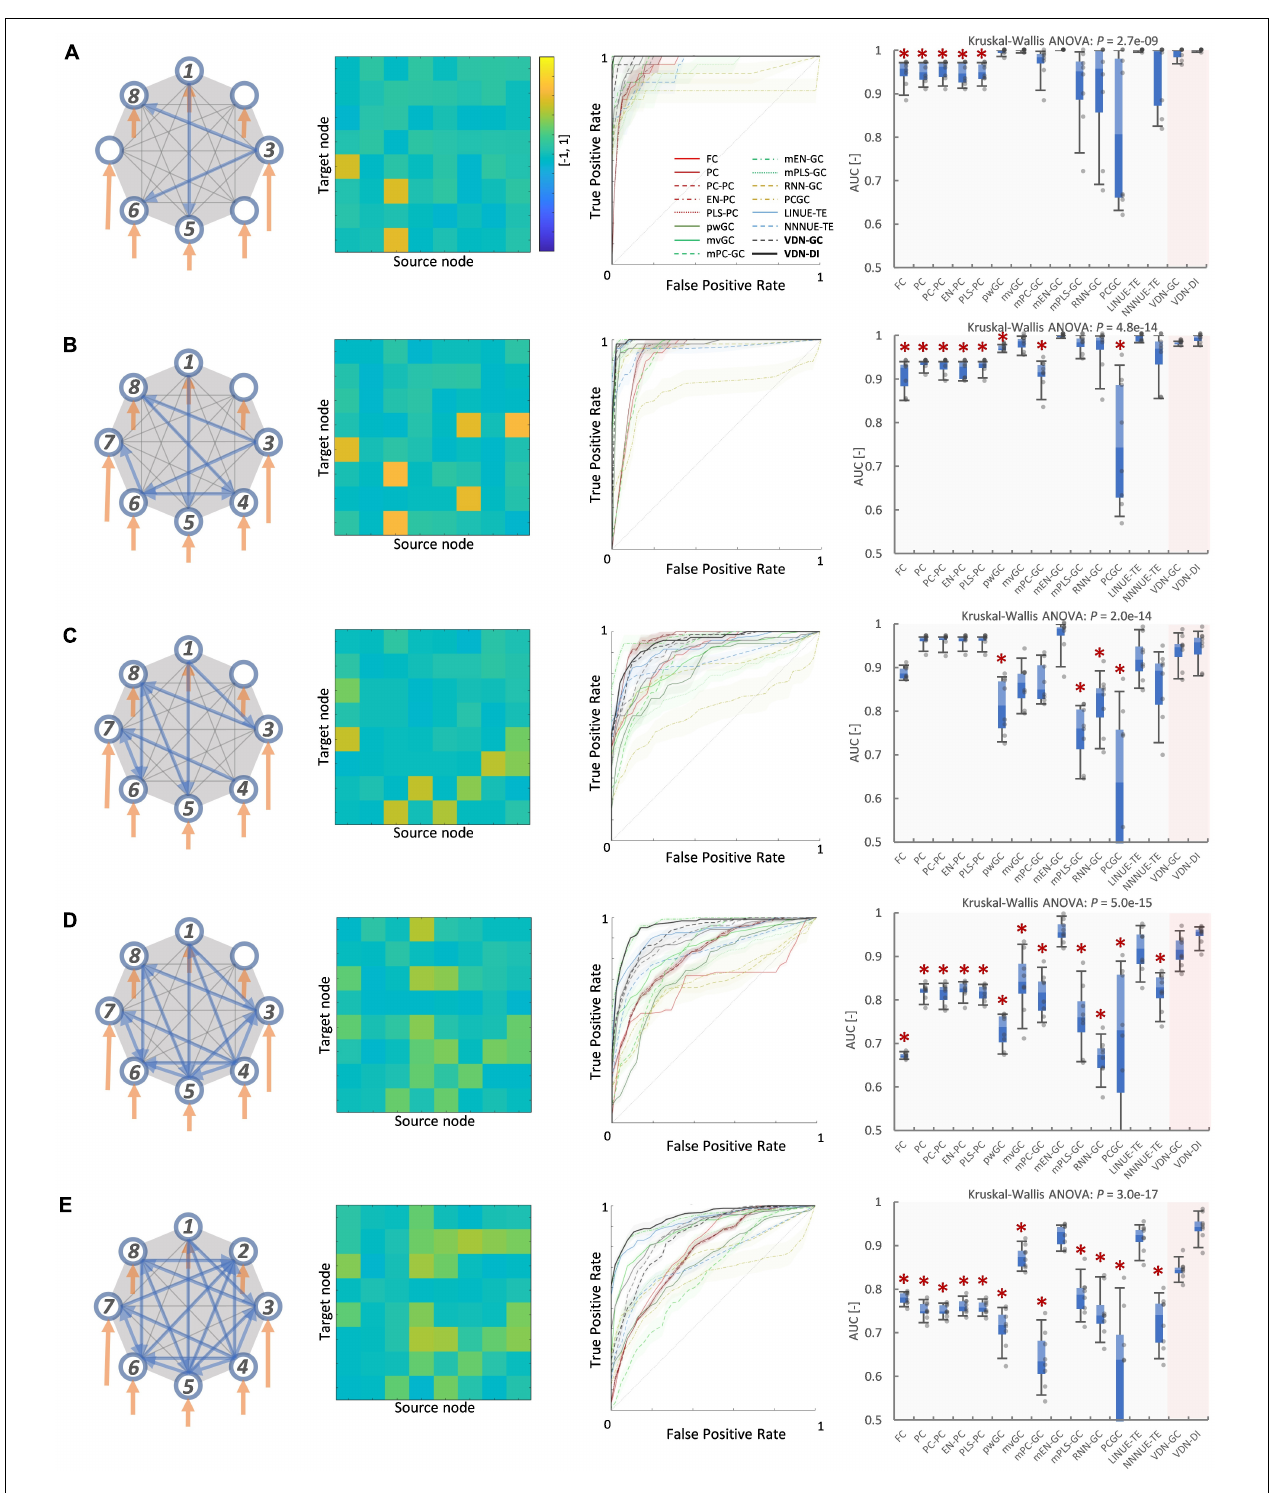
FIGURE 5 | (A) Fully connected 8-node network with strong weight (| aij| > 0.2) network density 0.05. From left to right, images show the ground truth network graph, the matrix A for DCM, the ROC curve result of ground truth estimation by each analysis algorithm, and the box-plot of AUC results, respectively. The color bar describes the matrix A- values for (A–E) . In the box-plot, a black dot shows each experimental result and a red asterisk shows significant difference from VARDNN-DI to other algorithms by Steel test (* p < 0.05) ( N = 8). (B) Result for the strong weight (| aij| > 0.2) network density 0.11 (fully connected 8-node network). (C) Result of strong weight network density 0.16. (D) Result of strong weight network density 0.27. (E) Result of strong weight network density 0.36.